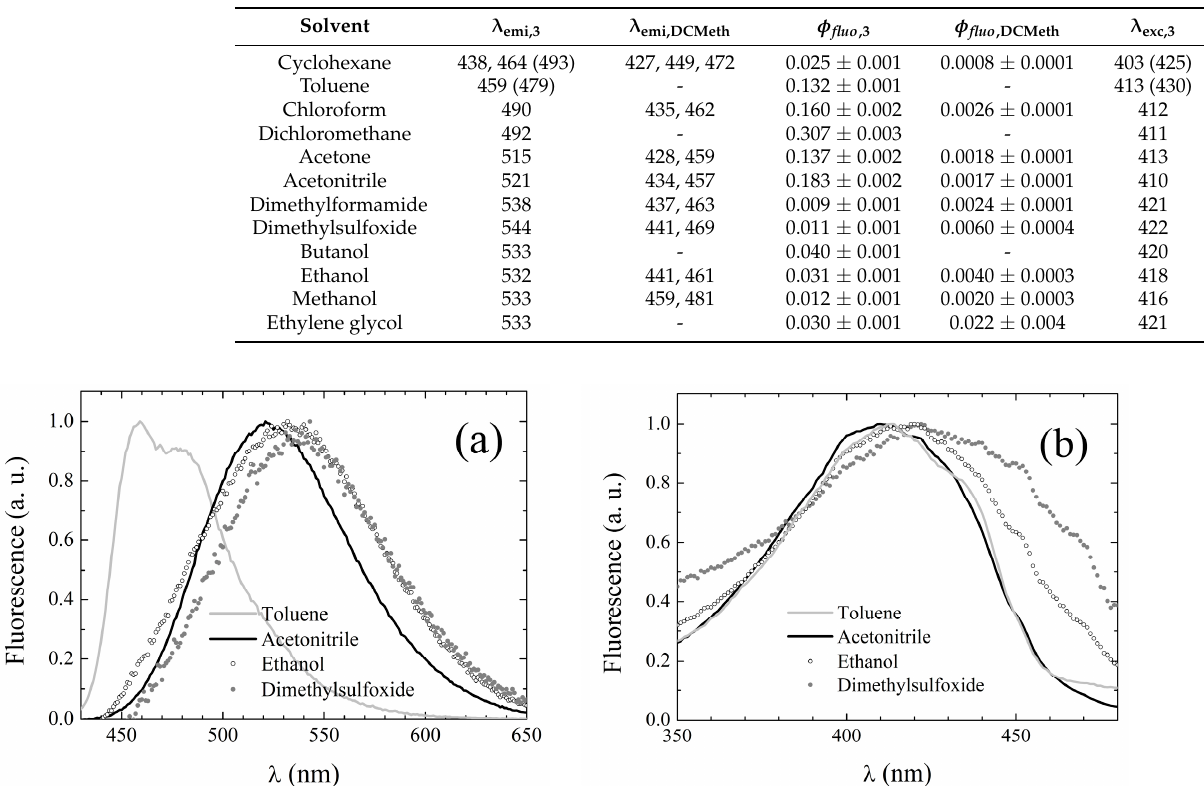
Figure 5. Fluorescence emission ( a ) and excitation ( b ) spectral line shapes of 3 in exemplary solvents. Unlike the absorption spectra, the emission spectra appear to resemble those of 1 rather than of DCMeth. First, the spectra of 3 are broad and structureless, with the exception of those acquired in non-polar solvents. In cyclohexane, the spectrum exhibits two peaks with a further shoulder at long wavelengths, while in toluene, the spectrum consists of a main peak and a red-shifted shoulder. Conversely, those of DCMeth were double-peaked in all of the tested solvents (see third column of Table 7). Moreover, the fingerprints of the solvent dependence of the fluorescence emission typical of 1 are also exhibited by 3 , even more neatly than by 2 . Although a direct correlation between peak emission wavelength and polarity is not observed, in the polar solvents, the emission spectrum is generally peaked at longer wavelengths than in inert ones. Furthermore, in the H-bonding solvents (both H- bond acceptors and alcohols), the fluorescence is systematically red-shifted with respect to polar weakly H-bonding solvents of comparable polarity. The fluorescence quantum yield of 3 (see fourth column in Table 3) is notably higher than that of 1 in non-polar (cyclohexane and toluene) and slightly polar (chloroform and dichloromethane) solvents, while it is comparable in highly polar environments and sizably lower in H-bonding solvents with the only exception of ethylene glycol. The comparison with 2 unravels a systematic reduction in the quantum yield for 3 with respect to the other asymmetric compounds, which might correlate with the specific phenolic substituents. Indeed, DCMeth was characterized by a particularly low quantum yield in all solvents [39] (the values are reported in the fifth line of Table 7 for the sake of straightforward